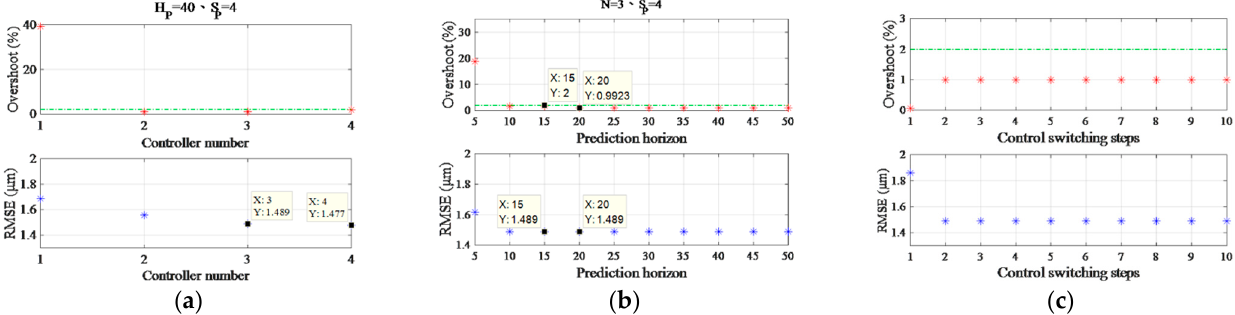
Figure A2. Iterative parameter tuning: ( a ) N optimization; ( b ) HP optimization; ( c ) SP optimization. Table A2. Iterative parameter tuning for the PZT stage.